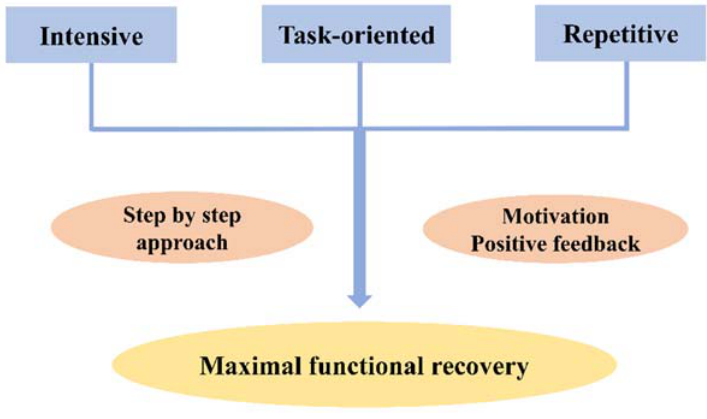
Figure 1. Approaches to promote neural plasticity.